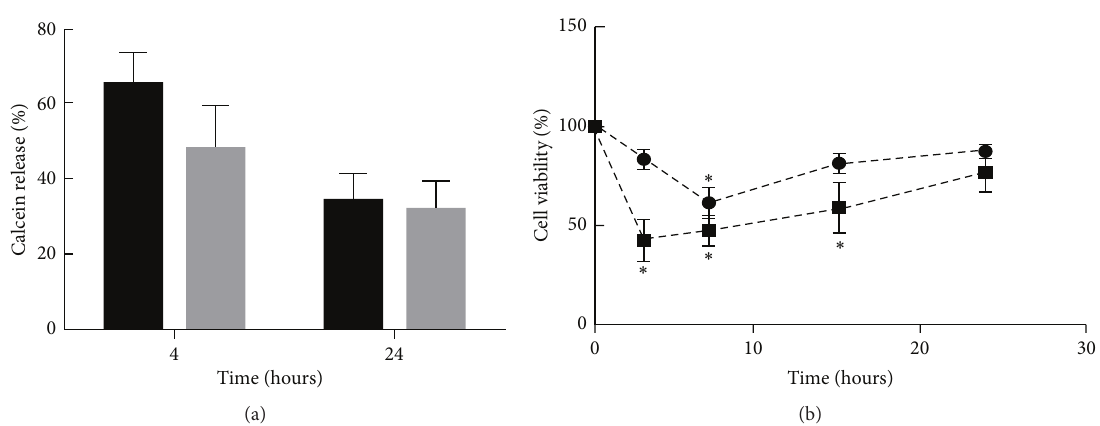
Figure 3: The effect of M. communis on the permeability and toxicity of 𝛼 -Syn. 𝛼 -Syn was incubated for different times in the presence ( ◼ , black) and absence ( e , gray) of M. communis (1% v/v). (a) The calcein release from DOPG vesicles after adding 𝛼 -Syn aggregates formed over 4 and 24 h. (b) The viability of the SH-SY5Y cells after 48h incubation with 𝛼 -Syn aggregated forms over different time (0–24 h). Each value represents the mean ± SD ( 𝑛 = 3 ). ∗ 𝑃 < 0.05 (Student’s t -test) indicated the samples are significantly different from the control. Controls are the viability of the SH-SY5Y cells treated with